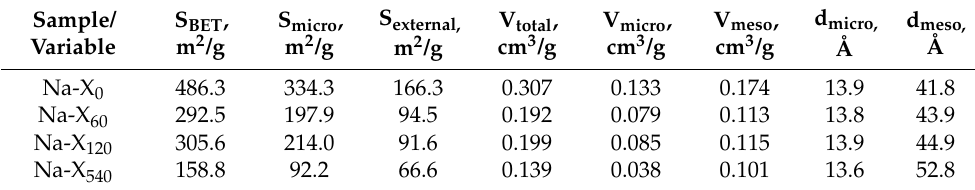
Table 1. Surface characteristics of parent and milled coal fly ash zeolite Na-X.